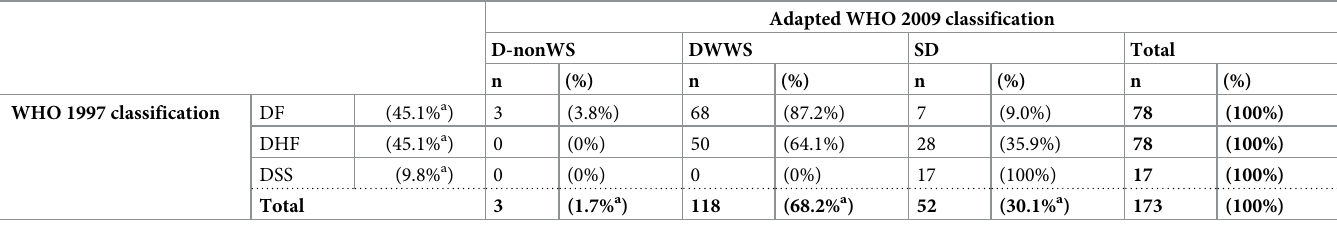
Table 3. Comparison of WHO 1997 and adapted WHO 2009 dengue classifications among hospitalized children with laboratory-confirmed dengue diagnoses (n = 173).